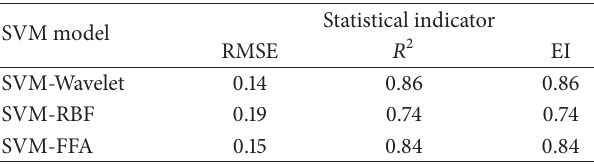
Table 5: Comparative performance statistics of the SVM-Wavelet, SVM-RBF, and SVM-FFA models for PCI